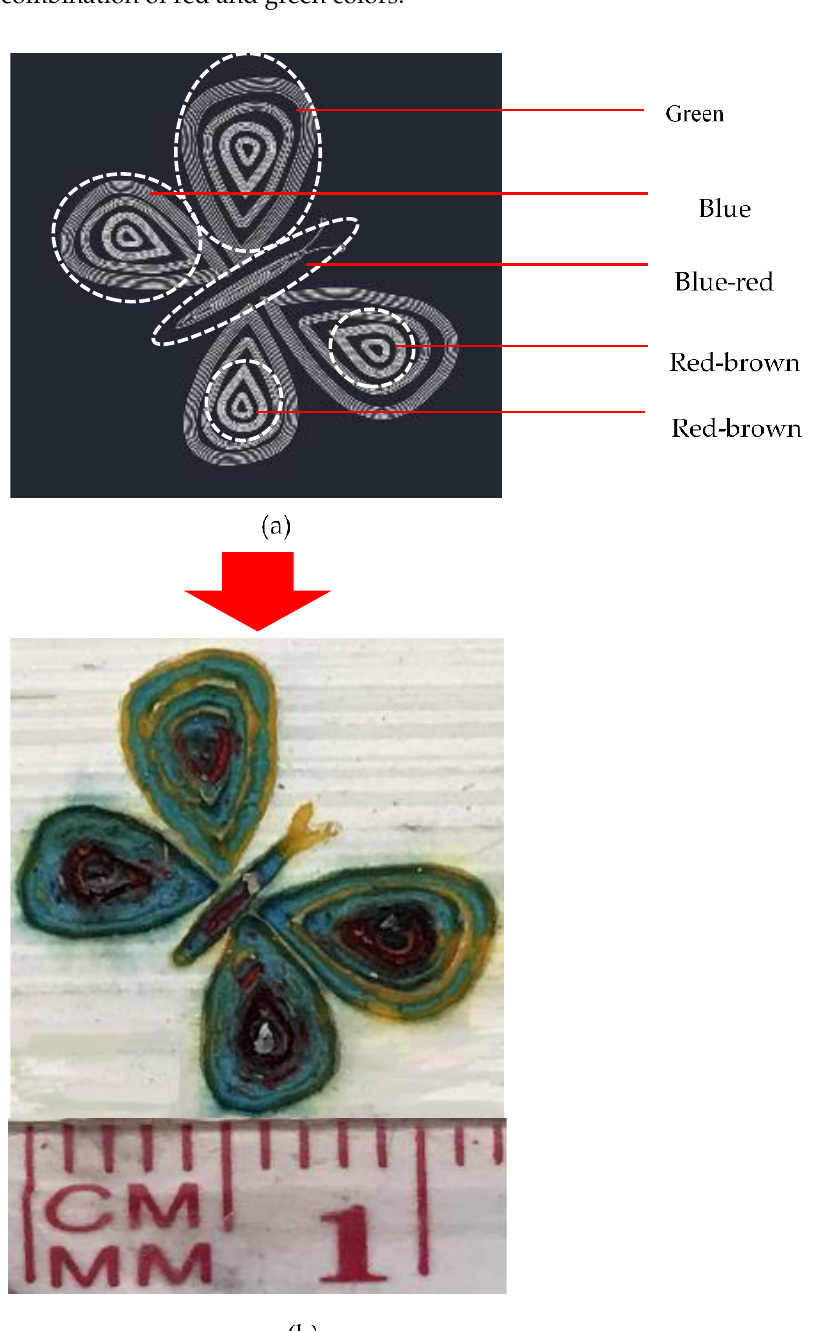
Figure 11. ( a ) CAD design of butterfly and definition of each part’s color. ( b ) Final output of laser painting.